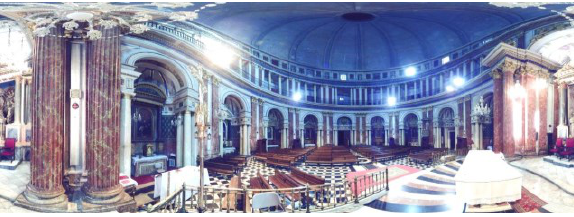
Figure 4. A panoramic view of laser scanner acquisitions The external survey was carried out using a Leica Scan Station. A survey with a thermal camera was also carried out. The IR shots were used to detect hidden cracks, above all in the dome. Figure 2. Plan and elevation of the Escuelas Pías Church (Verdú, 1996)